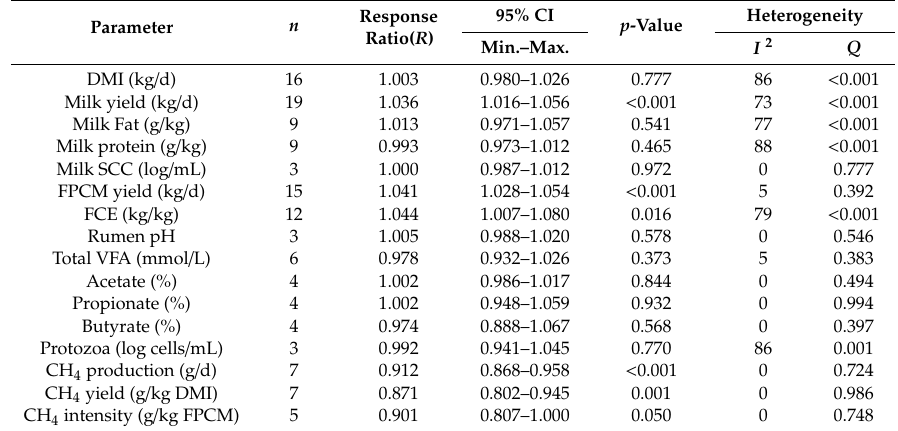
Table 5. Mean response ratio and estimated heterogeneity parameters describing the long term e ff ects ( ≥ 28 days of treatment) supplementing an essential oil blend (1 g / d per cow) to dairy cows. 95% CI p Heterogeneity Response -Value Parameter n Ratio( R )